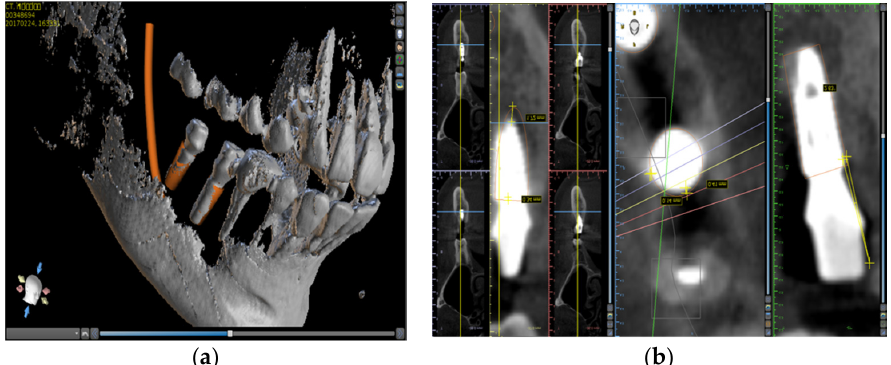
Figure 6. Deviations of the preoperatively planned implant position and the postoperative implant position: ( a ) 3D superimposed image; ( b ) measurements the distance and angulation difference.